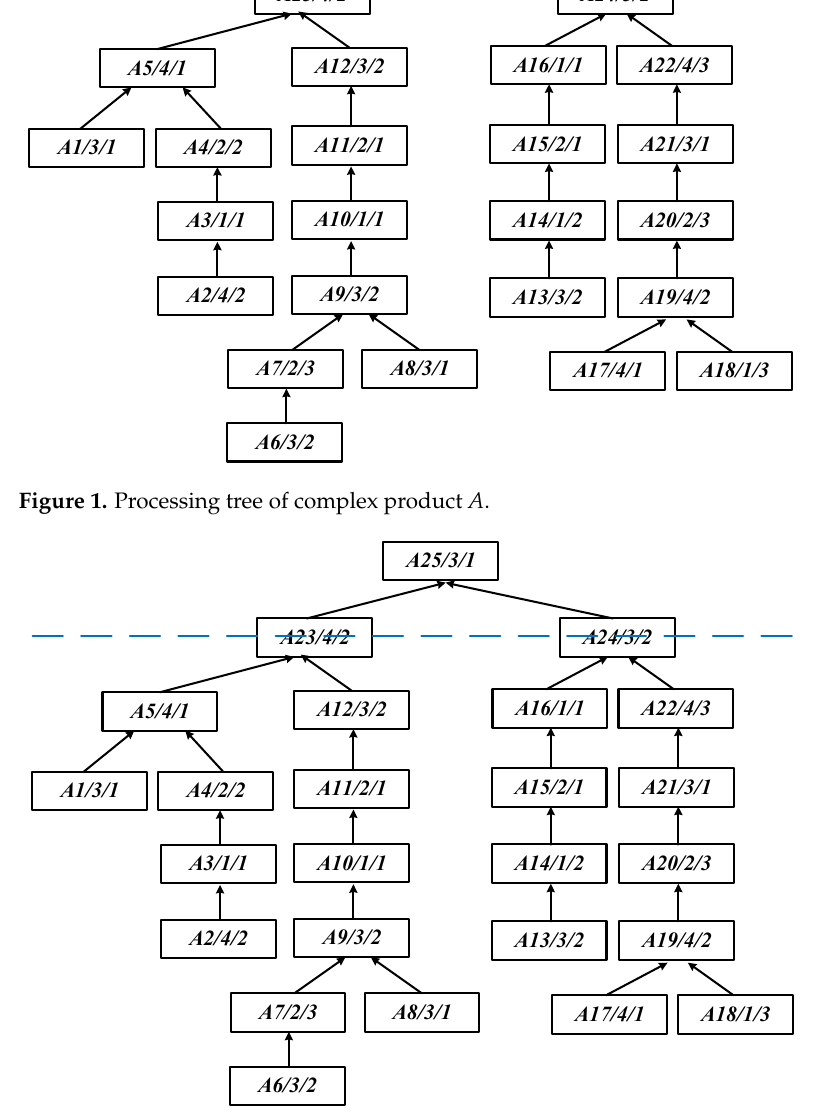
Figure 2. The decomposition diagram of complex product A (Blue lines represent cut sets).